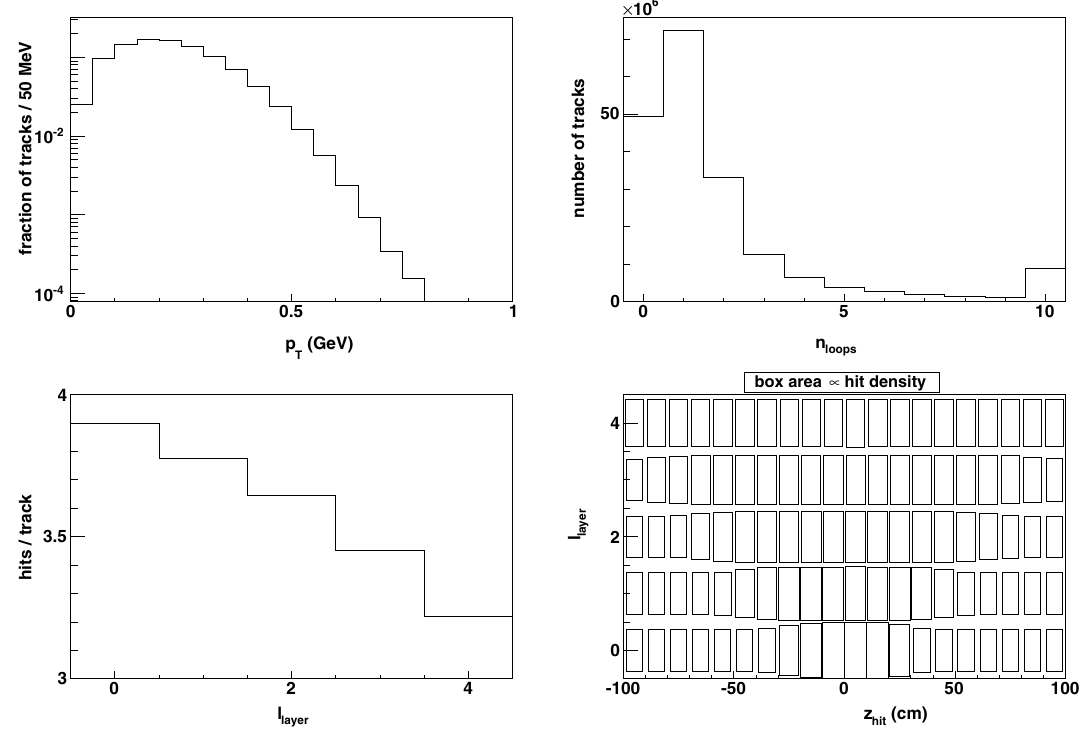
Figure 6. (top left) The generated distribution of the transverse momentum of pileup particles. (top right) The number of loops executed by the pileup particles in the magnetic field while traversing the barrel pixel layers. The last bin contains the overflow. (bottom left) The average number of hits deposited per layer by a pileup particle. (bottom right) The density of hits for each sensor layer as a function of the longitudinal